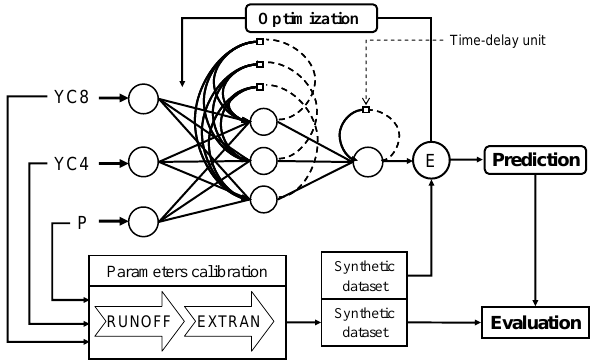
Figure 5 The architecture of a RNN to predict the water level at the ungauged station 655 Fig. 5. The architecture of a RNN to predict the water level at the ungauged